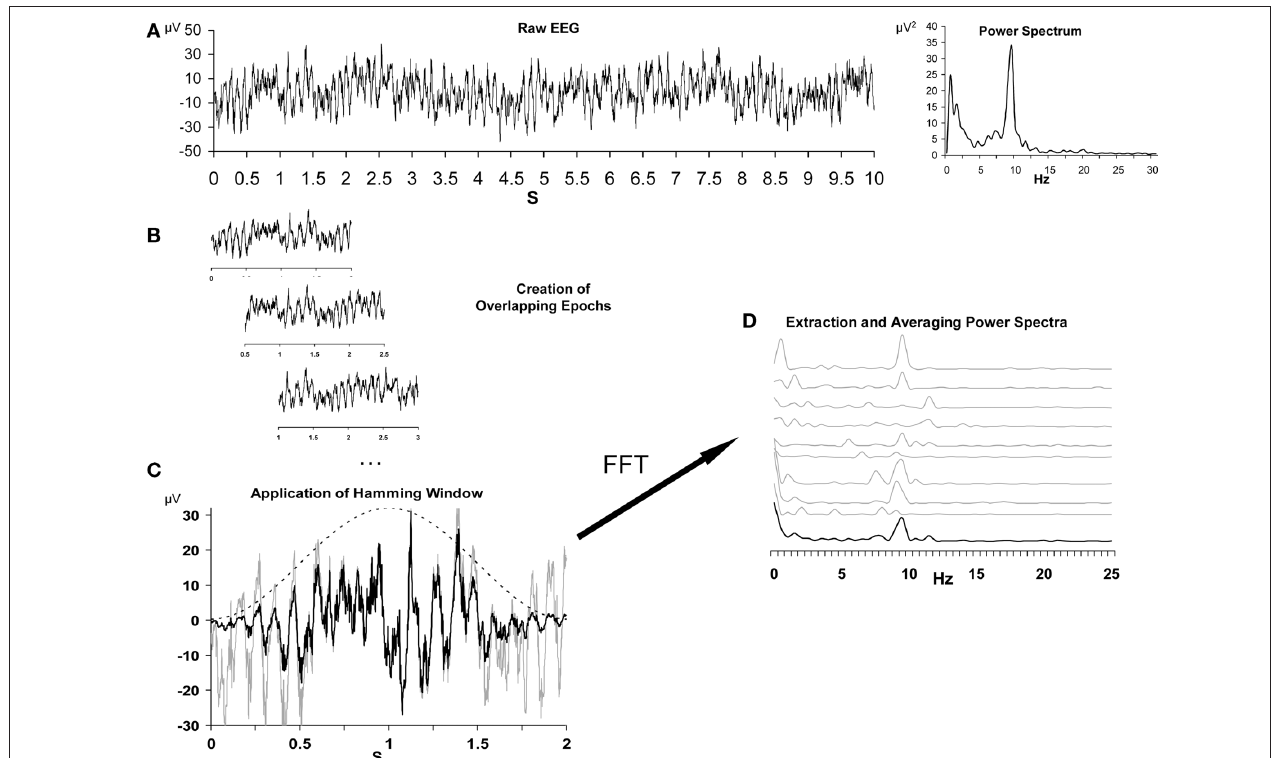
window. Panel D illustrates the extraction of individual power spectra via FFT, and finally the averaging of those spectra across epochs. The top nine gray lines are the spectral representation of nine 2 s epochs, and the lower black line is the average spectrum. Note that alpha power (8–13 Hz) is somewhat variable from epoch to epoch, but that the average spectrum reveals a distinct alpha peak. Vertical axis in (D) is power in microvolts-squared. Figure modeled after Allen et al.